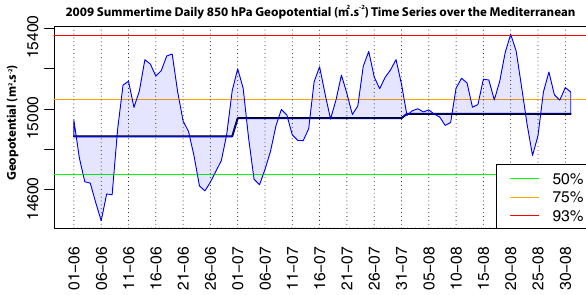
Figure 12. Same as Fig. 9 for the summer of 2009.